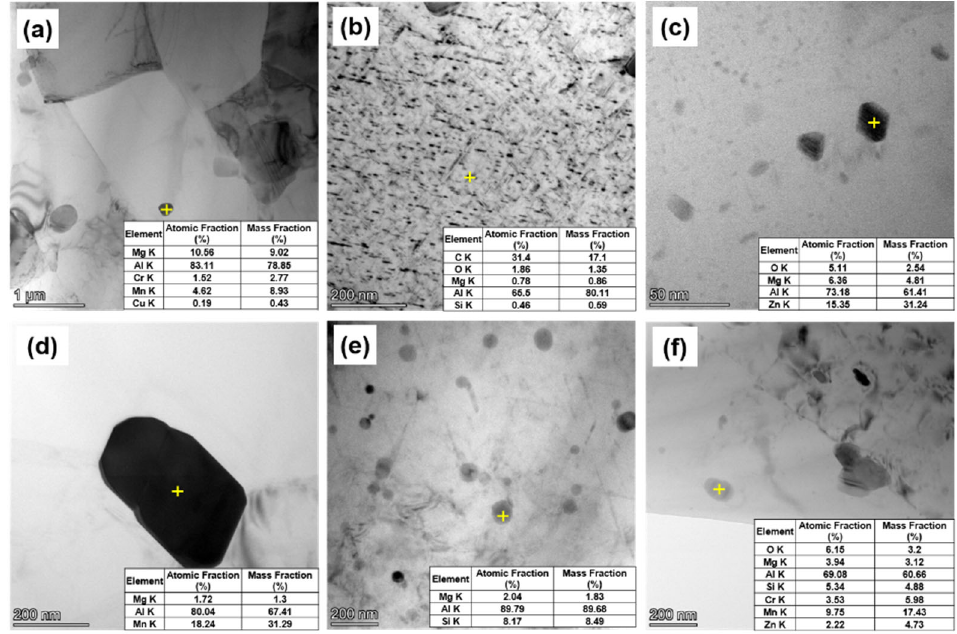
Figure 9. EDS results of different aluminum alloy welded joints: 5083: ( a ) BM; ( d ) HAZ; 6005A: ( b ) BM; ( e ) HAZ; 7N01: ( c ) BM, ( f ) HAZ.